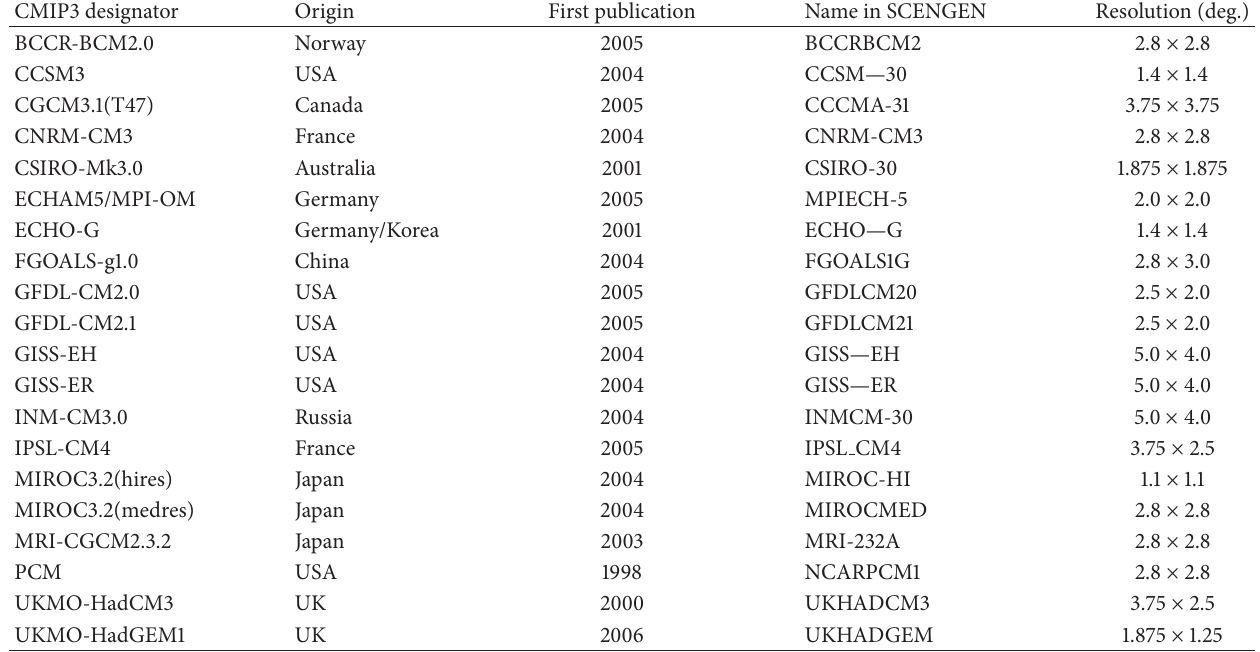
Table 1: Global climate models used for climate change scenarios generation in this study.